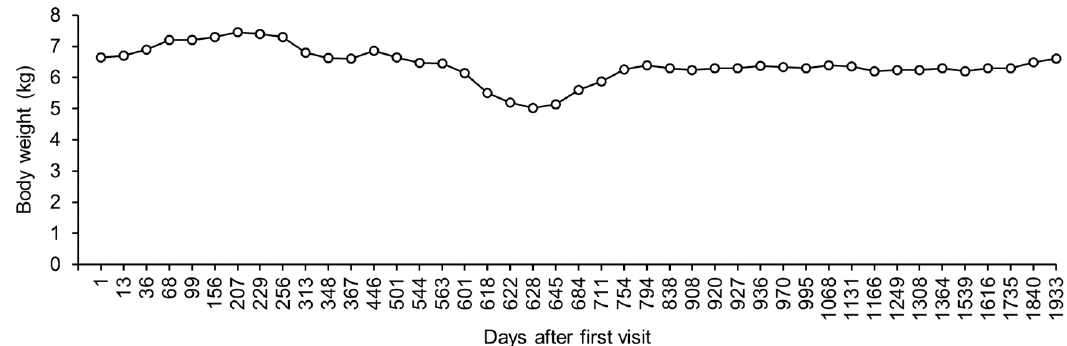
Figure 2. Change in body weight. Body weight was measured at least once every 10 days. Only the representative values are shown.